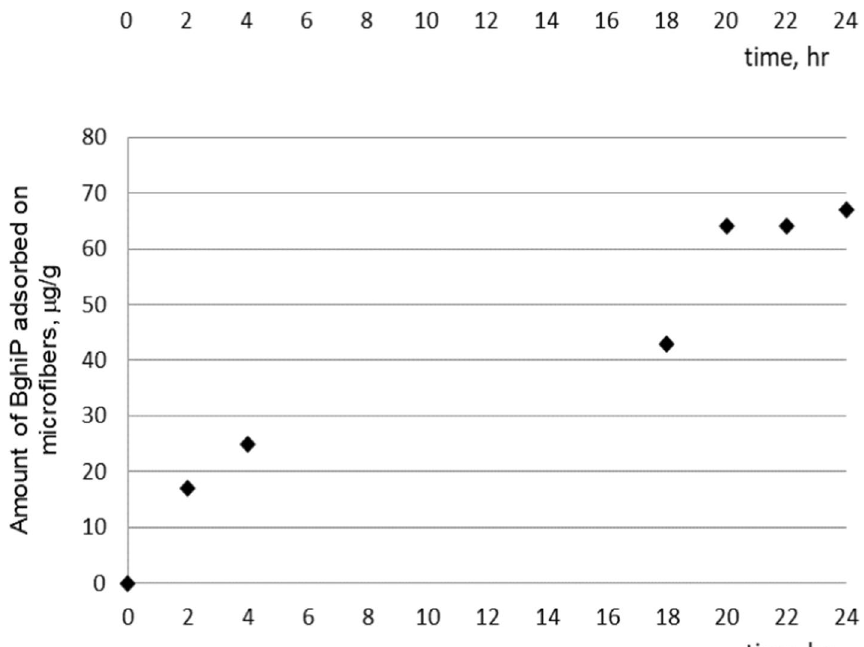
Fig. 8 Benzo(ghi)perylene (μg/g) adsorbed on microfibers as a function of